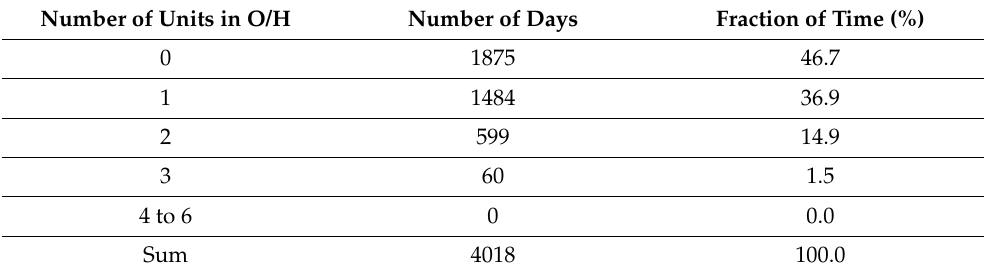
Table 2. Fraction of time for each number of units in O/H.